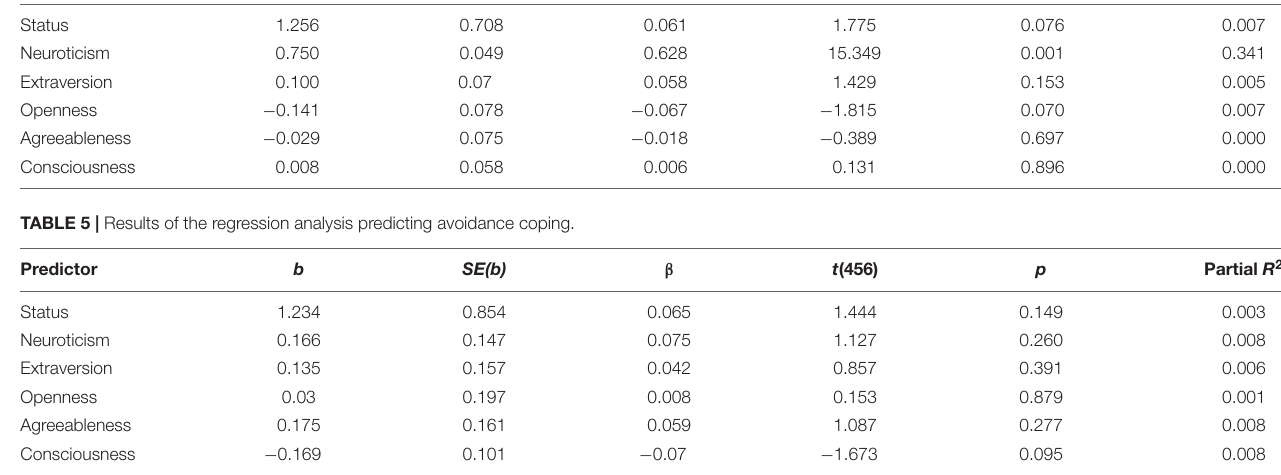
TABLE 4 | Results of the regression analysis predicting emotion-oriented coping. Predictor